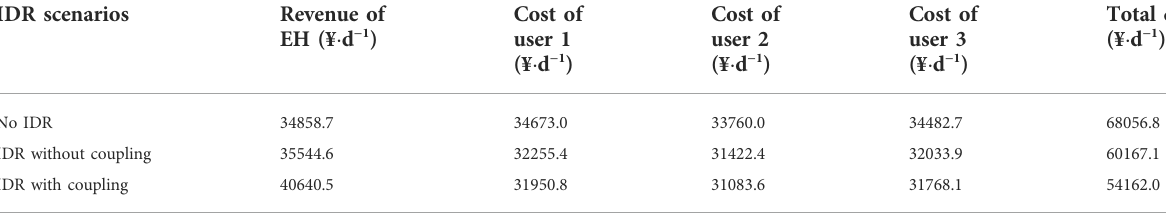
TABLE 1 The cost of decentralized robust optimal dispatch for each agent under different IDR